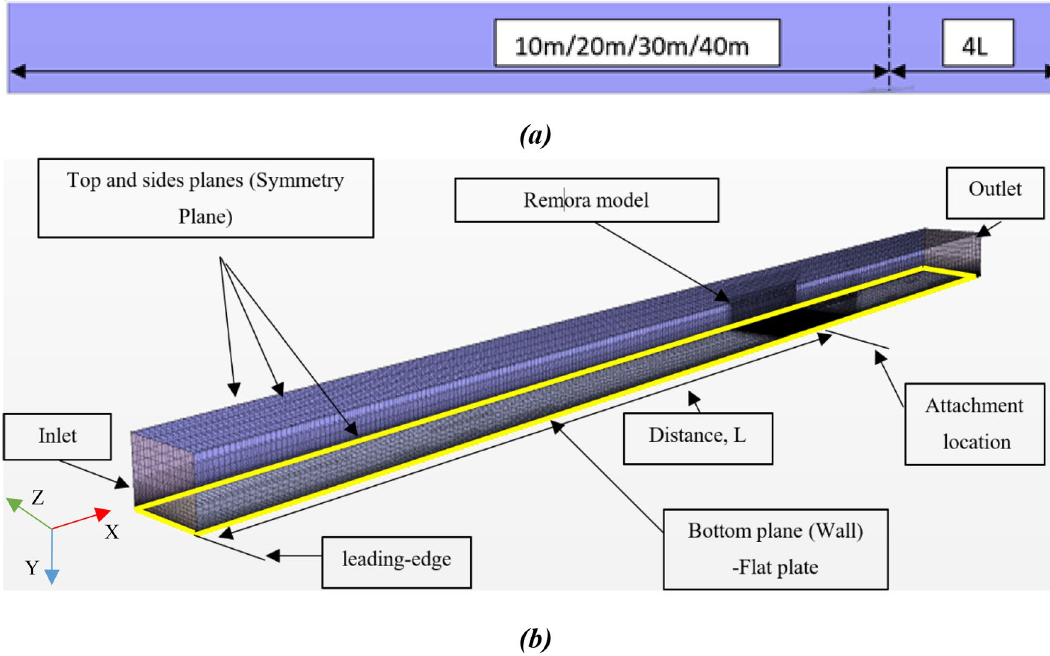
Figure 10. Domain and boundary conditions of the flat plate simulation, a) side view and b) three-dimensional view of the domain (Created using Simcenter STAR-CCM + 2019.2.1 Build 14.04.013).